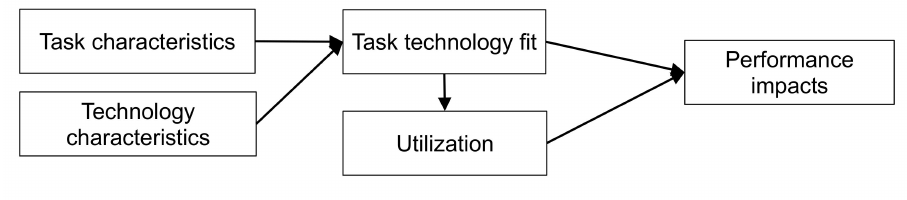
Figure 3. Reduced task–technology fit [28] (Goodhue and Thompson,